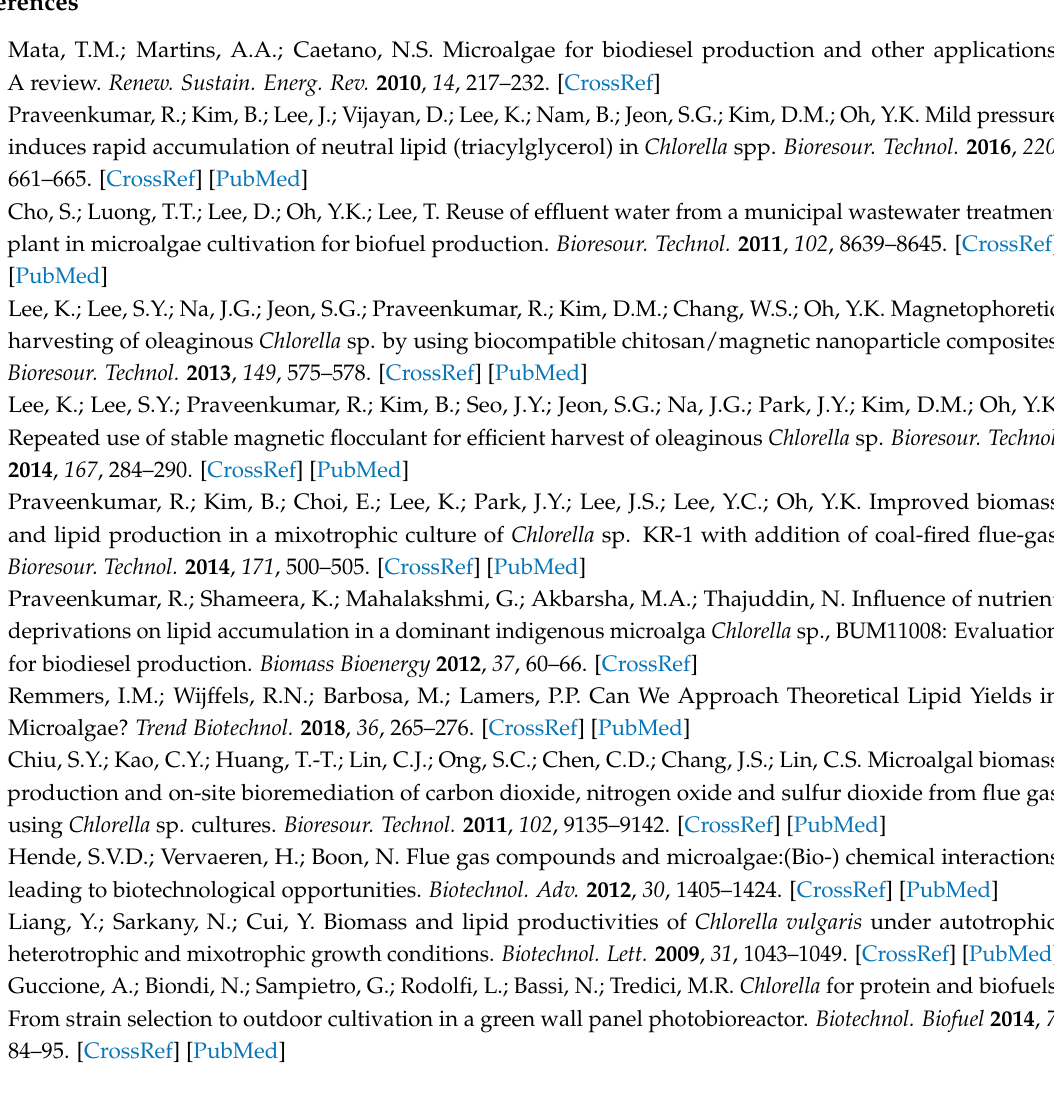
Figure S1: Growth curve of 6 fast-growing Chlorella strains under autotrophic and mixotrophic conditions for 96 h of cultivations, Figure S2: FAME distributions of 6 fast-growing Chlorella strains under autotrophic and mixotrophic indoor conditions for 96 h of cultivation, Figure S3: FAME distribution of 3 high-productivity Chlorella strains in outdoor culture mediated by coal-fired flue-gas, and Figure S4: Growth patterns of 3 high-productivity Chlorella strains under high-temperature